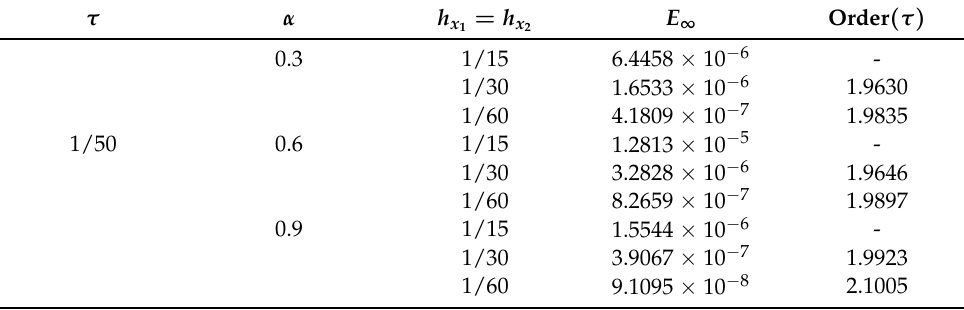
Table 4. The maximum error and convergence order in time-dimension for Example